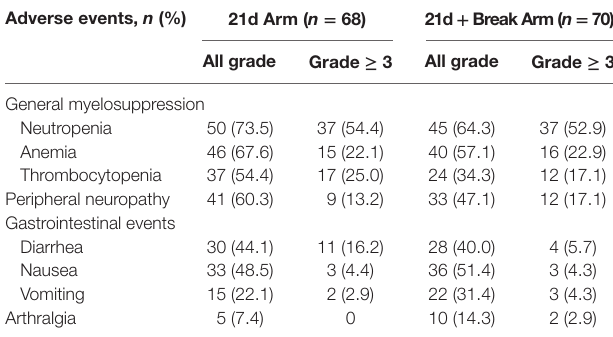
TaBle 4 | Adverse events of special interest.